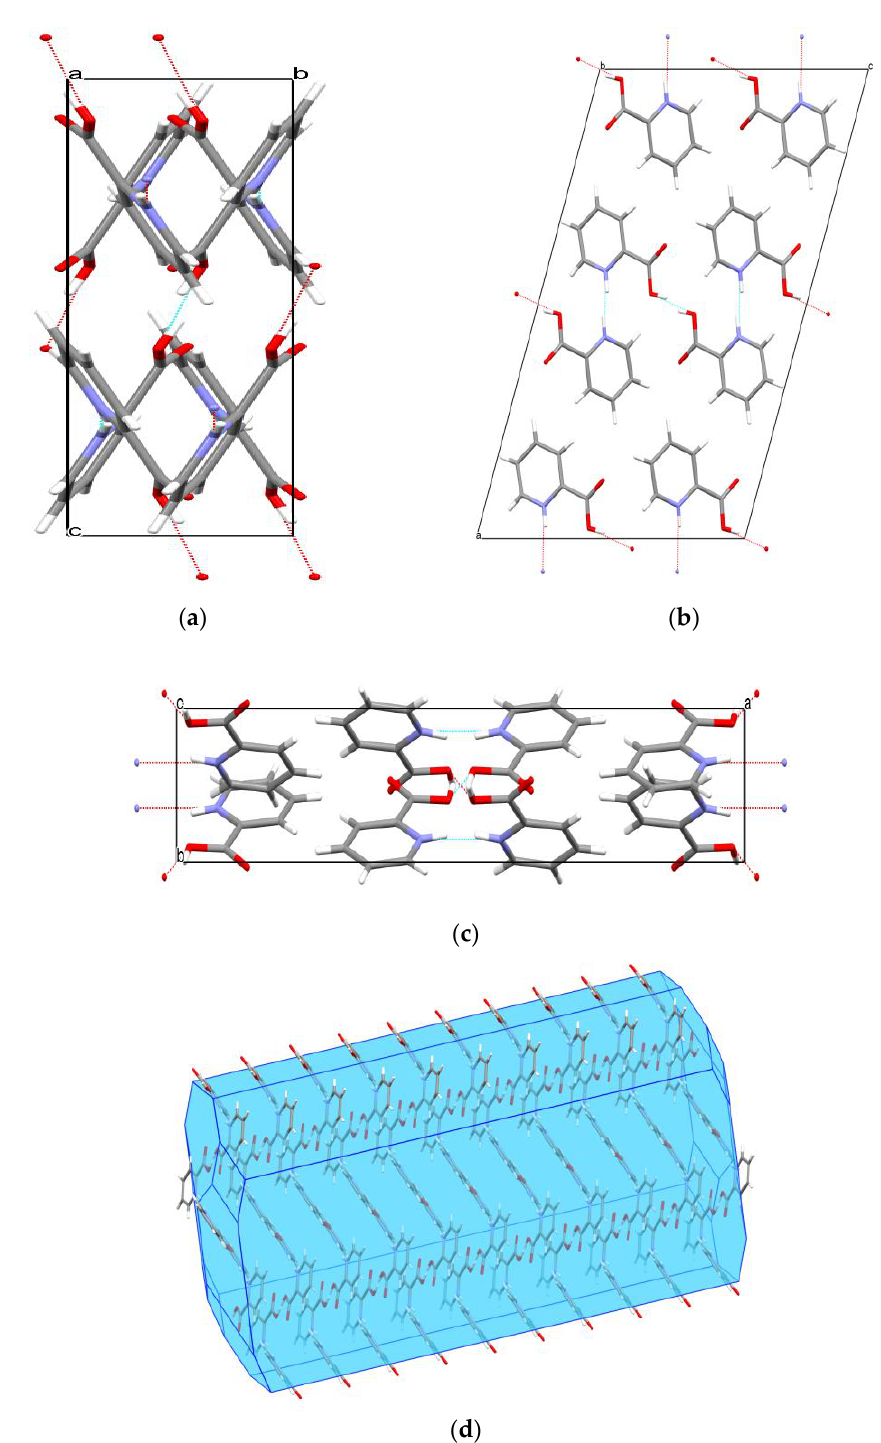
Figure 4. Views of the crystal (small, prismatic, and colorless, achieved by sublimation on a petri dish) structure of picolinic acid (PA) along a ( a ), b ( b ), c ( c ) axes, and the Bravais-Friedel-Donnay-Harker (BFDH) morphology ( d ) determined from single crystal X-ray diffraction data using Mercury 2020.2.0 (Build 290188) program